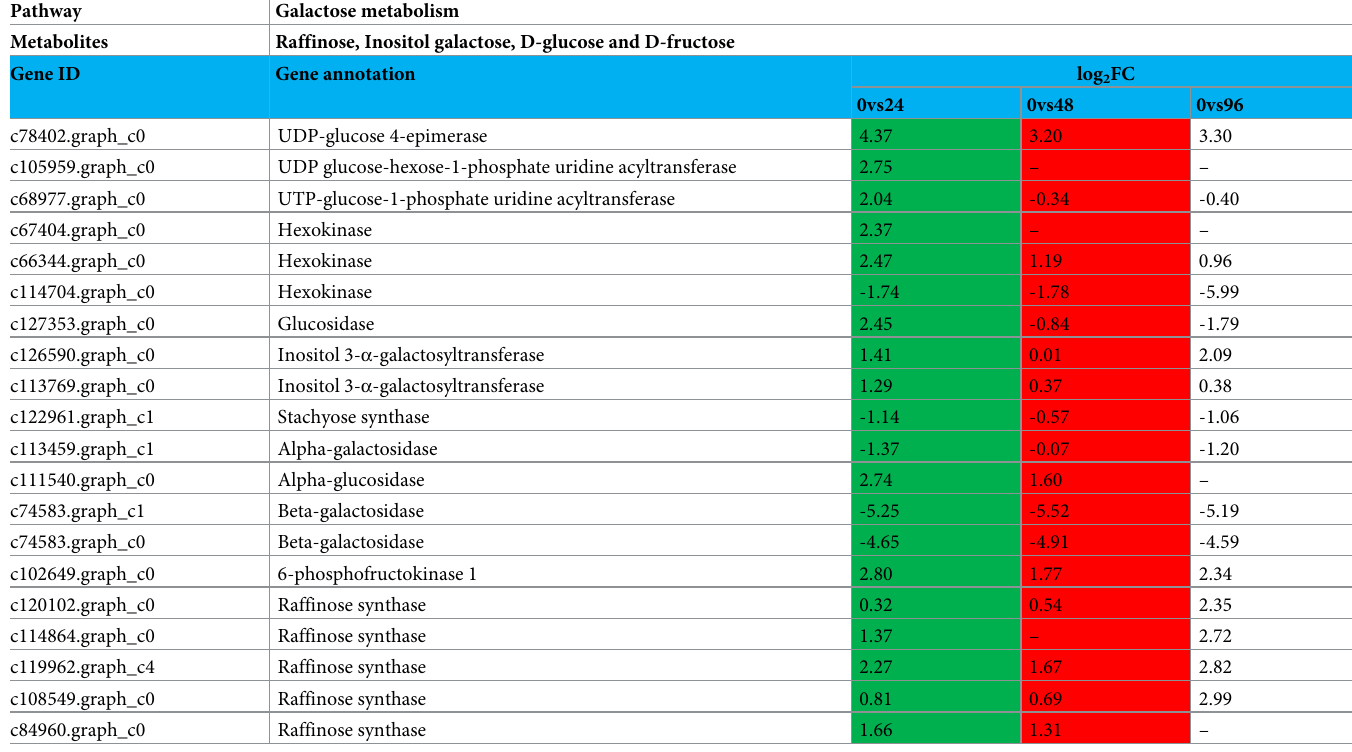
Table 7. Annotation of differentially expressed genes in response to drought in galactose metabolites of Larix olgensis .